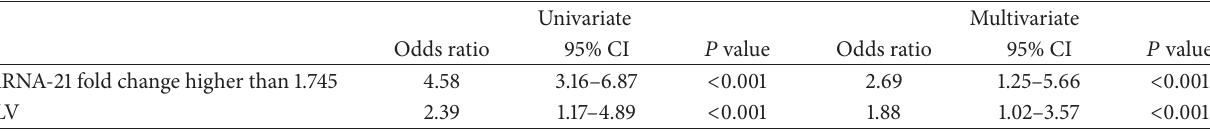
Table 5: Univariate and multivariate logistic regression of the relationships between MiRNA-21, OLV, and PPCs. Univariate Multivariate miRNA-21 fold change higher than 1.745